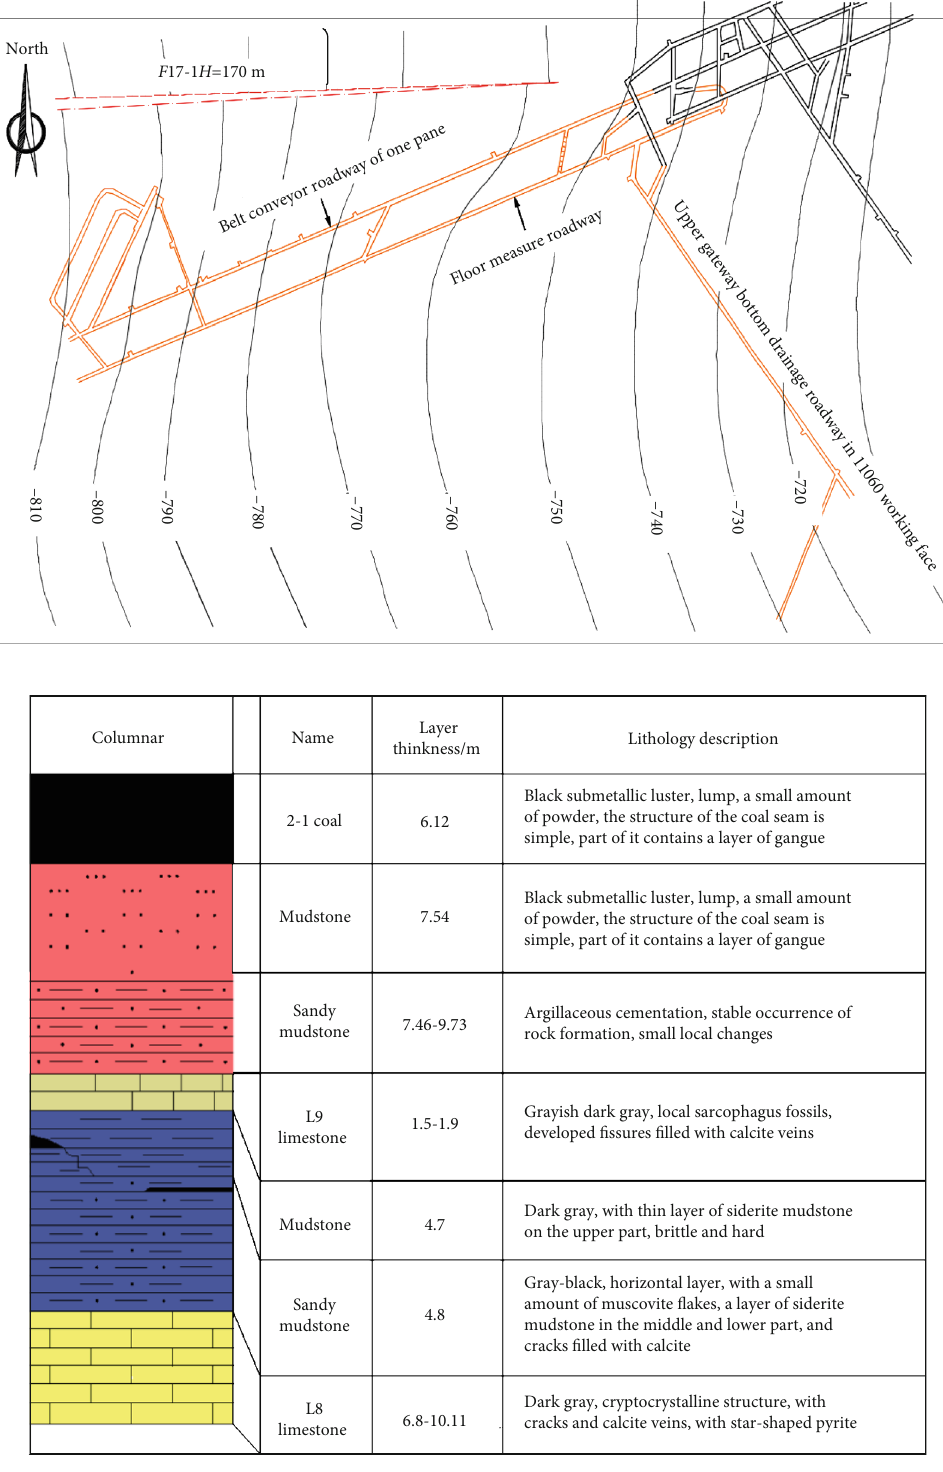
Figure 1: The FGER layout and comprehensive columnar diagram of coal fl oor rocks of the Zhaogu No. 2 coal